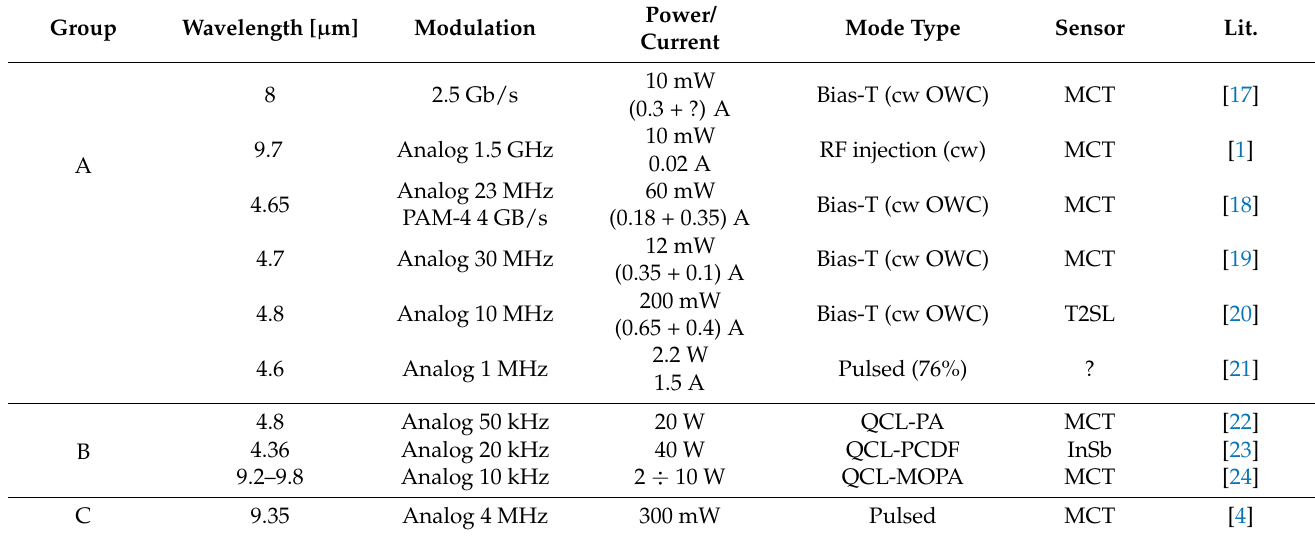
Table 2. MWIR radiation sources and detectors applied to transmit optical signals in a free space. Group Wavelength [ µ m]